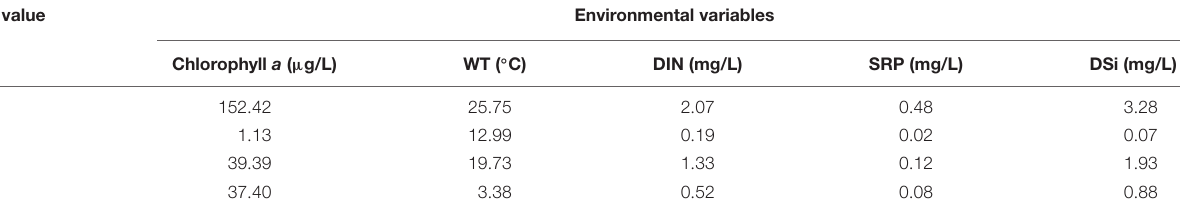
TABLE 1 | Descriptive statistics of environmental factors measured in the Xiangxi Bay of Three Gorges Reservoir.